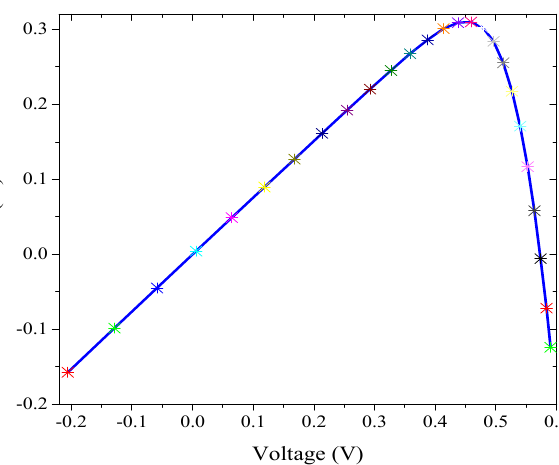
Figure 6. I–V curve of the measured and calculated currents for the single-diode cell.